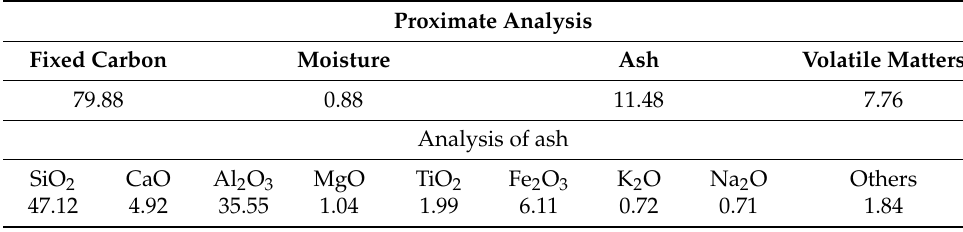
Table 1. Proximate and chemical analyses of the UPC, wt%.